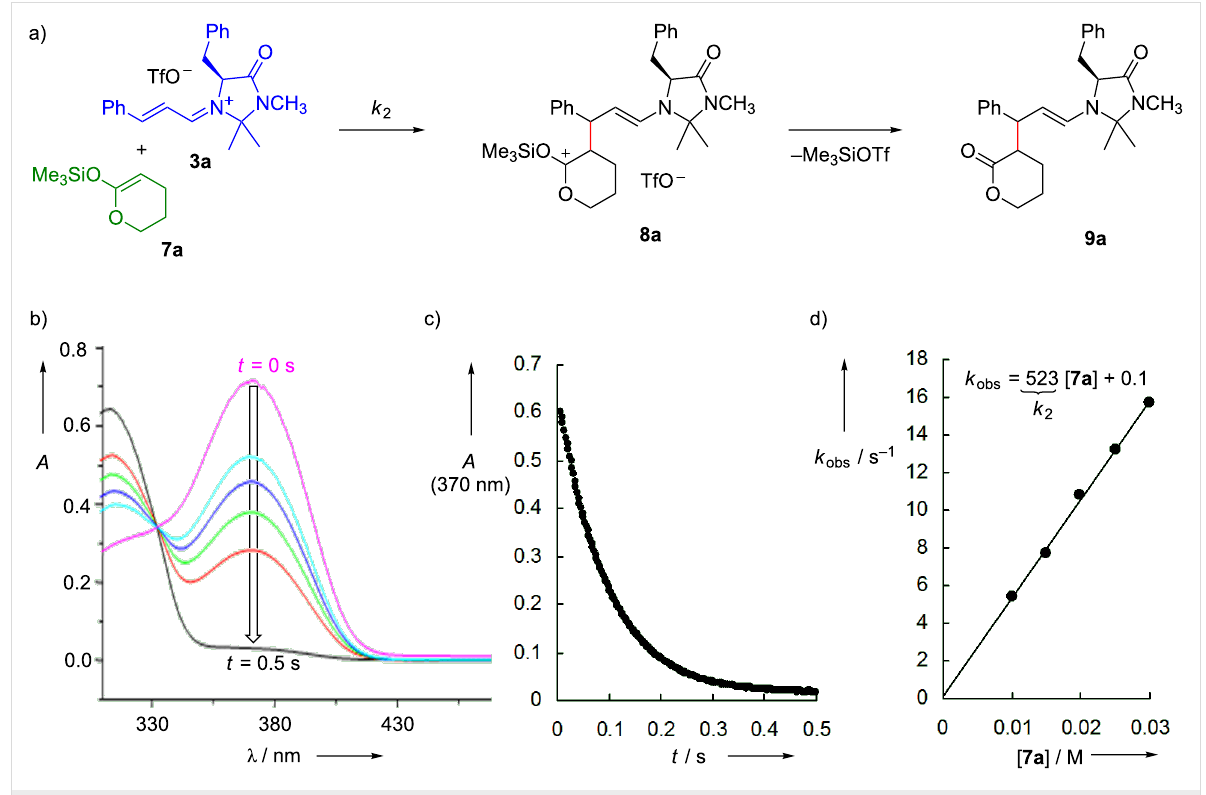
Figure 3: Kinetics of the reactions of the iminium ion 3a with the silylated ketene acetal 7a [35].